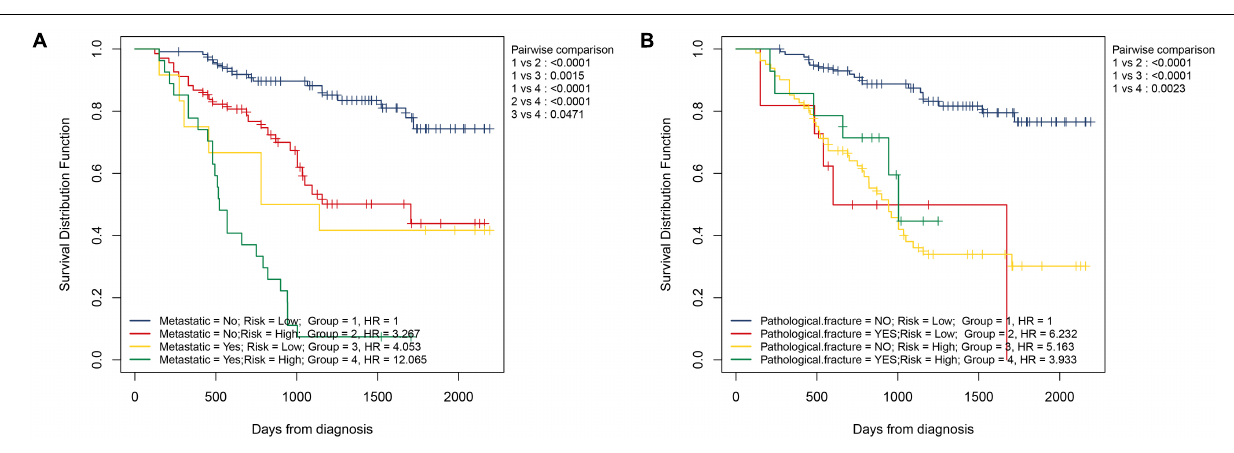
FIGURE 6 | NMRS can further identify patients with different risks on the basis of clinical characteristics. (A) Two-factor KM survival curves considering the risk of NMRS and the status of tumor metastasis; (B) Two-factor KM survival curves considering the risk of NMRS and the status of pathological